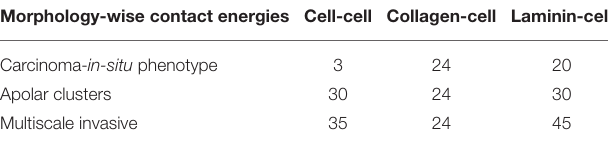
TABLE 1 | Contact energies for simulations of discrete cancer morphologies. Morphology-wise contact energies Cell-cell Collagen-cell Laminin-cell Carcinoma- in-situ phenotype 3 Apolar clusters Multiscale